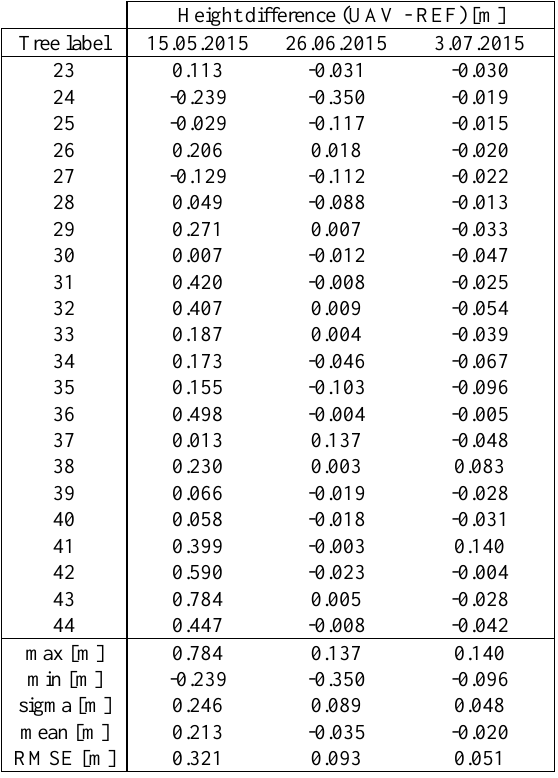
Table 1. Height differences and statistics